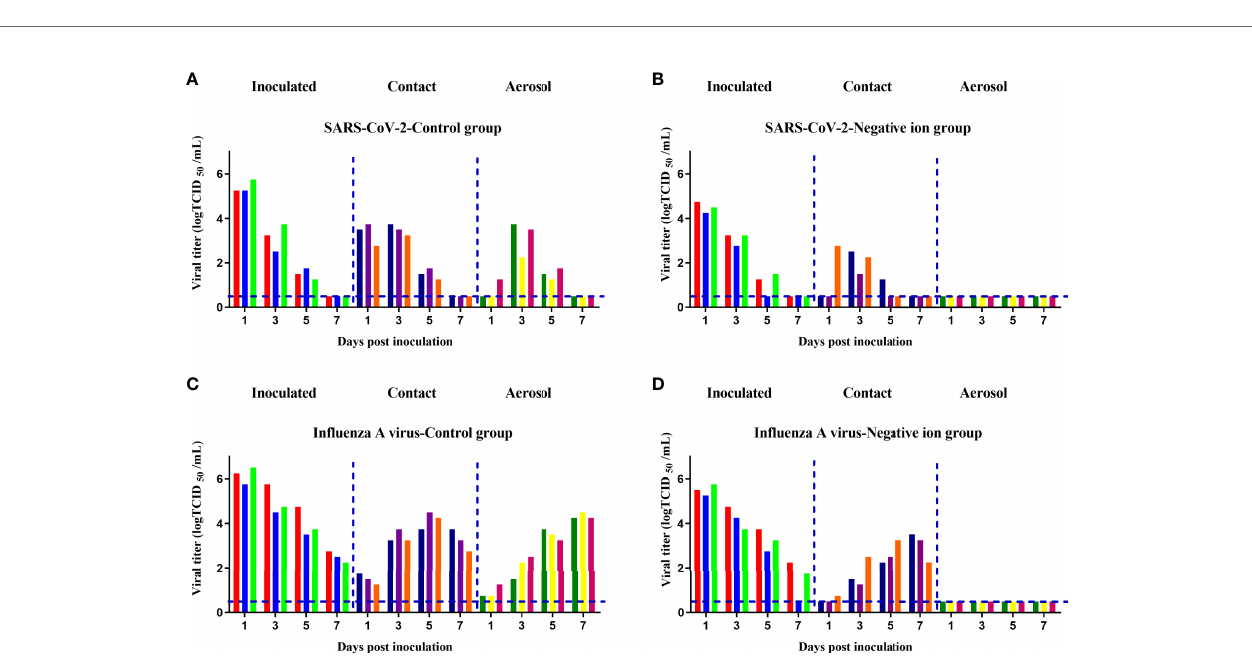
FIGURE 6 | Aerosoltransmissionofthepandemicsevereacuterespiratorysyndromecoronavirus2(SARS-CoV-2) (A,B) andin fl uenzaAvirus (C, D) wasblockedbynegative ions. Sixdonoranimalsper groupwereintranasallyinoculatedwith105mediantissuecultureinfectivedose(TCID50)ofthe corresponding virus.At24hpostinoculation, 3 donorsper groupwere transferredtoanewcageandcohousedwiththreenaiveanimalsfor thedirectcontacttransmissionstudies,andanother 3donors per groupwere transferredtoawire-framecageadjacenttoanother 3naiveanimalsfor theaerosoltransmissionstudies. Nasalwashesoftheseanimalswerecollectedandtitratedat1,3,5,and 7dayspostinoculationorexposure.Eachcolor barrepresents thevirustiter inanindividualanimal.Dashedlinesindicatethelowerlimit